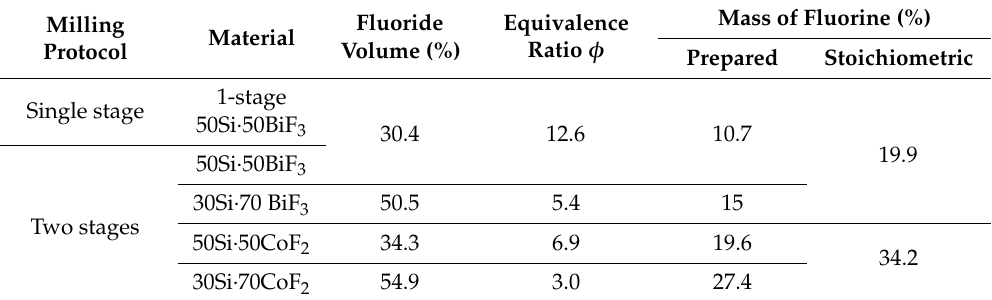
Table 2. Compositions of prepared silicon-metal fluoride reactive